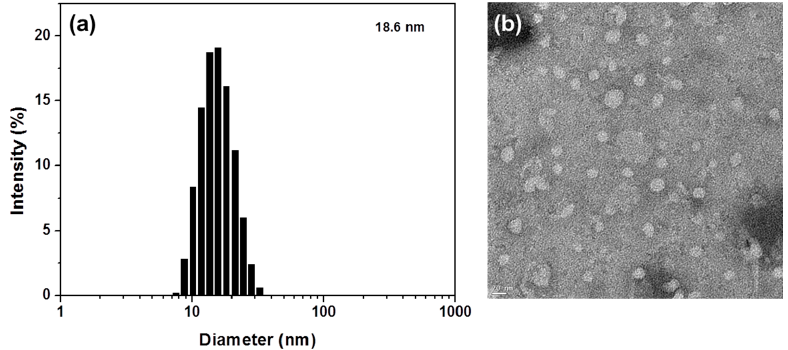
Figure 3. ( a ) Dynamic light scattering (DLS) diagram of poly(ethylene glycol)-cholesteryl conjugate (Chol-ss-PEG-ss-Chol) micelles; and ( b ) transmission electron microscopy (TEM) image negatively stained with phosphotungstic acid hydrate (scale bar, 20 nm).